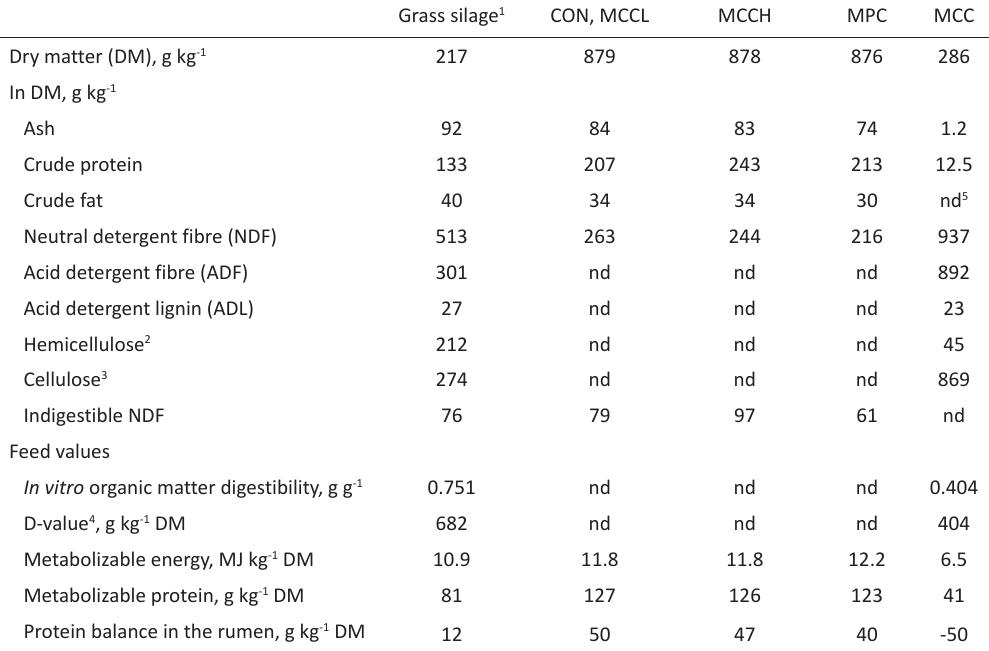
Table 2. Chemical composition of the experimental